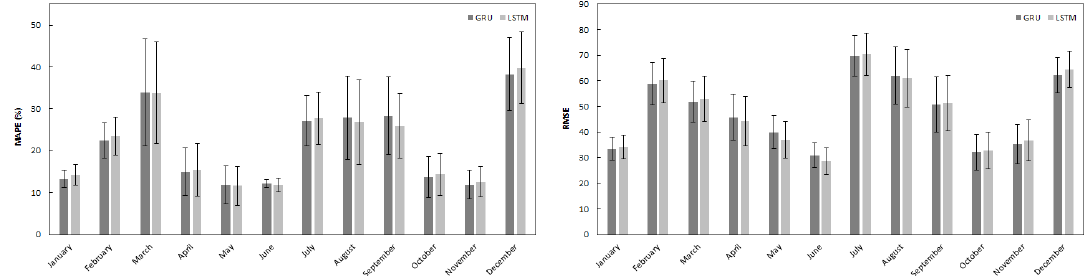
Figure 4. Average MAPE and RMSE values with corresponding standard error for each month using multivariate GRU and Long Short-Term Memory (LSTM) with cloud